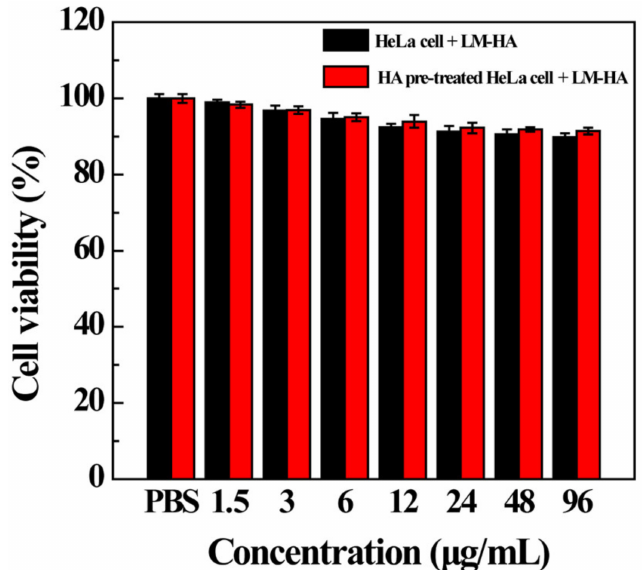
Figure 6. MTT viability assay of HeLa cells and HA pre-treated HeLa cells treated with LM-HA for 24 h,